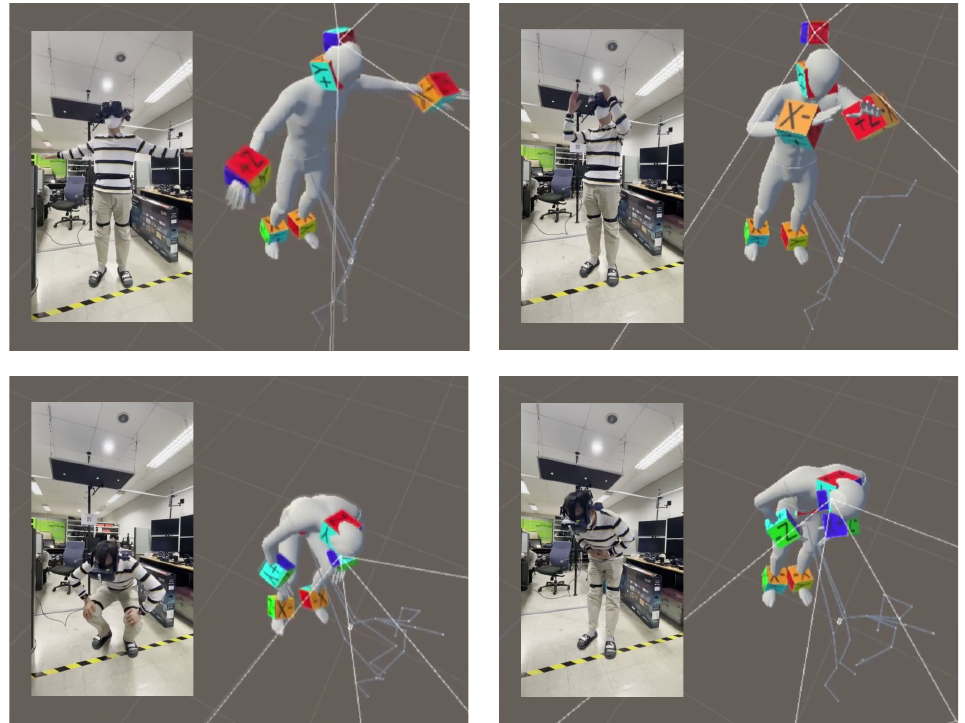
Figure 12. The real-time application using sample frames in Unity 3D. Our implemented application took the HMD sensor as input and reconstructed the 3D modeling body after a slight